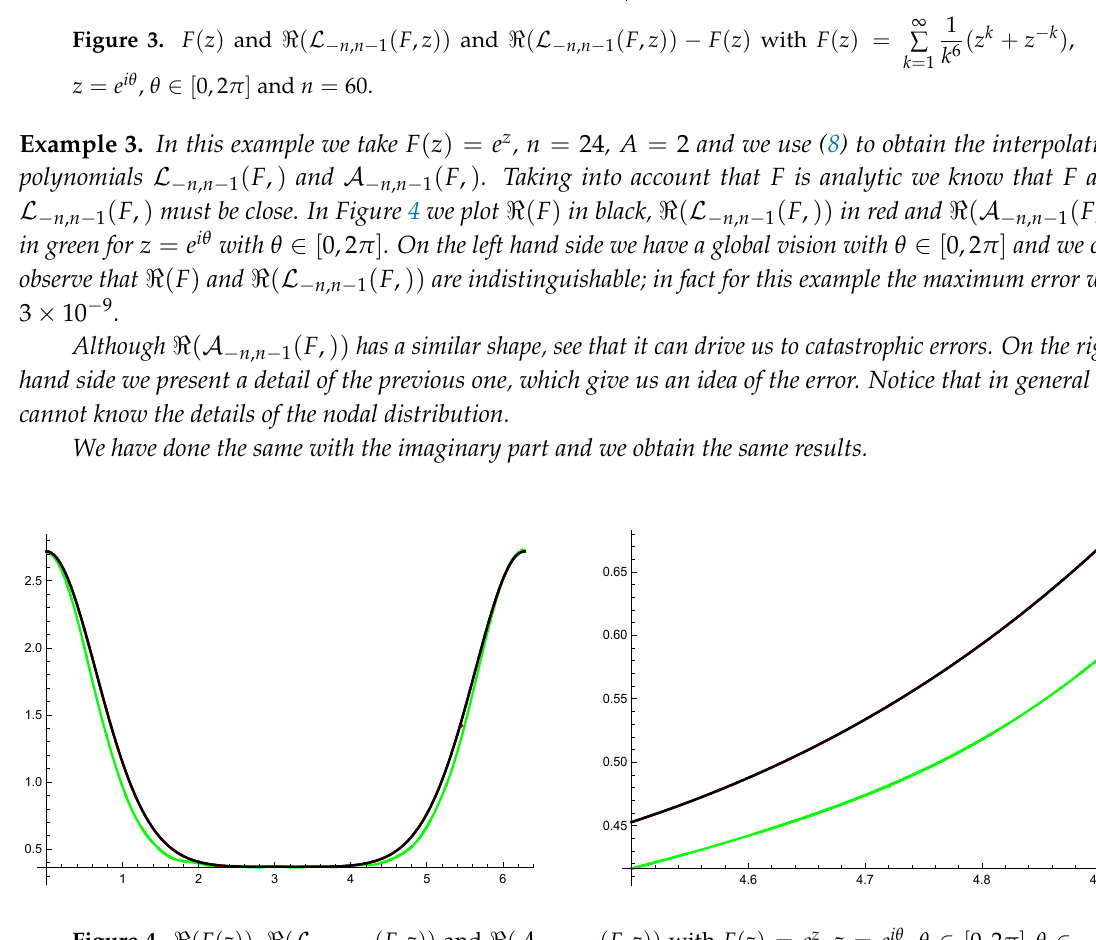
∞ 1 ∑ ( z k + z − k ) , k 6 k = 1